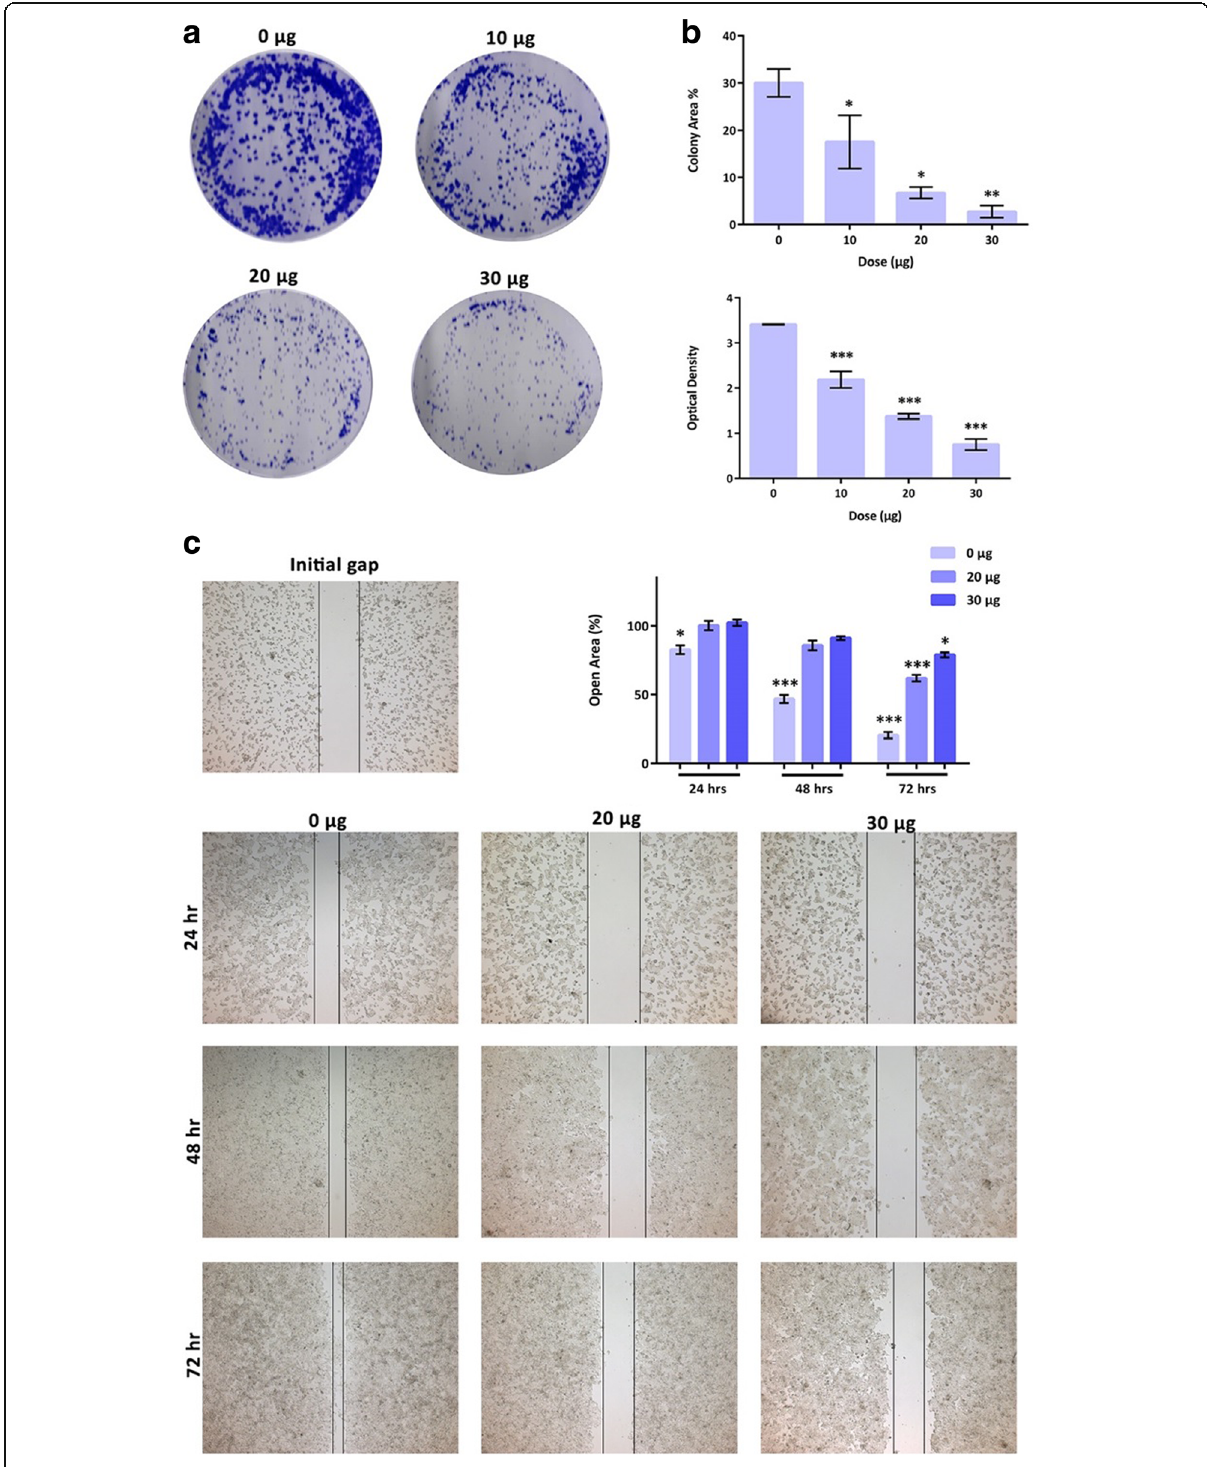
Fig. 6 Rhazya stricta extract inhibits colony forming ability and wound healing of HepG2 cells in a dose-dependent manner. a Representative images of HepG2 colonies after treatment with increasing concentrations of R. stricta extract. b Percent of area occupied by colonies in treated and non-treated wells (representative of triplicate samples; * P <0.05, ** P <0.005, *** P <0.0001) and absorbance of each treated and non-treated wells (representative of 3 biological triplicates, each in triplicate; * P <0.05, ** P <0.001, *** P <0.0001). c Representative images and quantification (three regions of three biological triplicates; * P <0.05, ** P <0.001, *** P <0.0001) of wound-healing assay results of HepG2 cells treated without or with 20 and 30 μ g of R. stricta